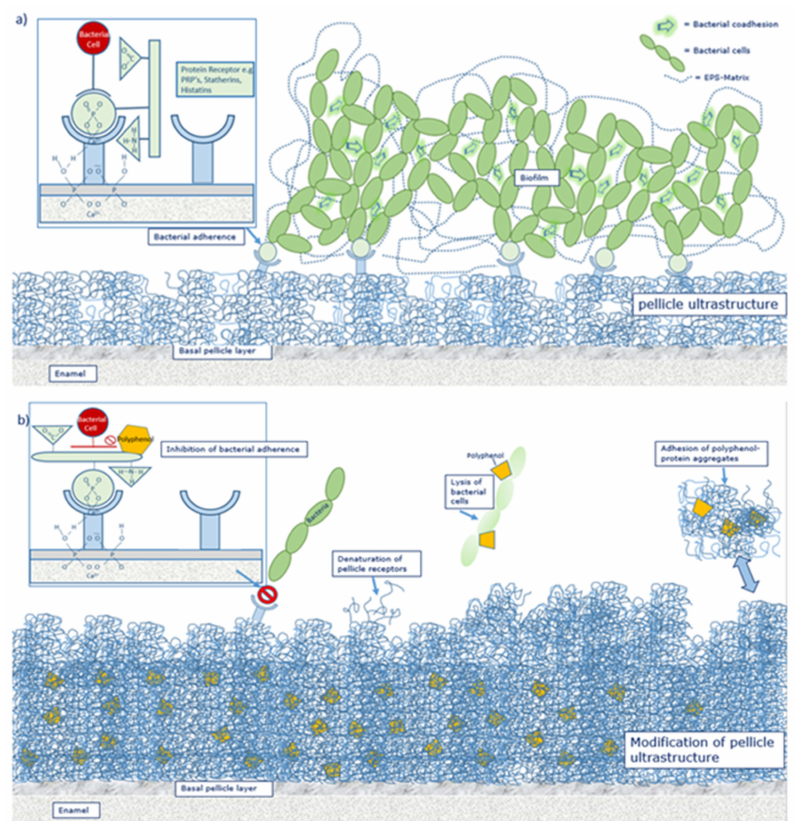
Figure 6. Denaturation of pellicle proteins through polyphenols. ( a ) Simplified representation of the pellicle ultrastructure on the tooth surface with an attached three-dimensional biofilm. Thereby, some proteins serve as receptors for bacterial cells to adhere to the tooth surface. ( b ) Hampered bacterial adhesion at the tooth surface. Polyphenols cause denaturation and changes in secondary and tertiary structure of proteins. In the following binding of bacteria to the polyphenol-modified- receptors is inhibited. Polyphenols also lead to a lysis of bacterial cells. In addition, polyphenol- protein aggregates adhere at the tooth surface. Consequently, the pellicle is denser and thicker in its